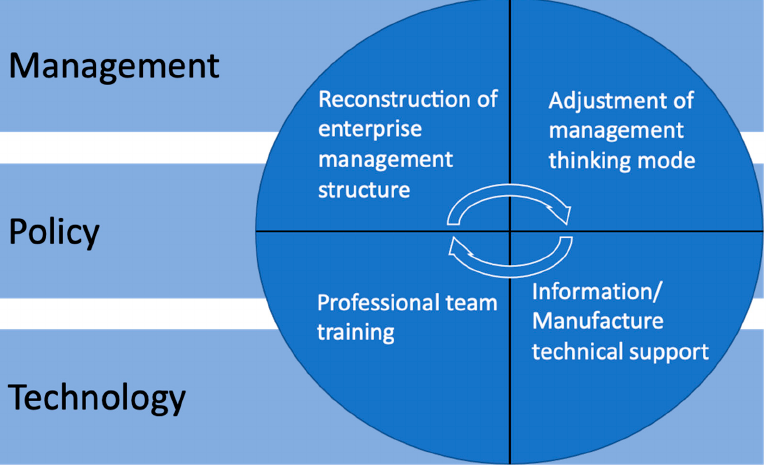
Figure 23. Factors influencing digital transformation of manufacturing enterprises (own elabora ‐ tion).